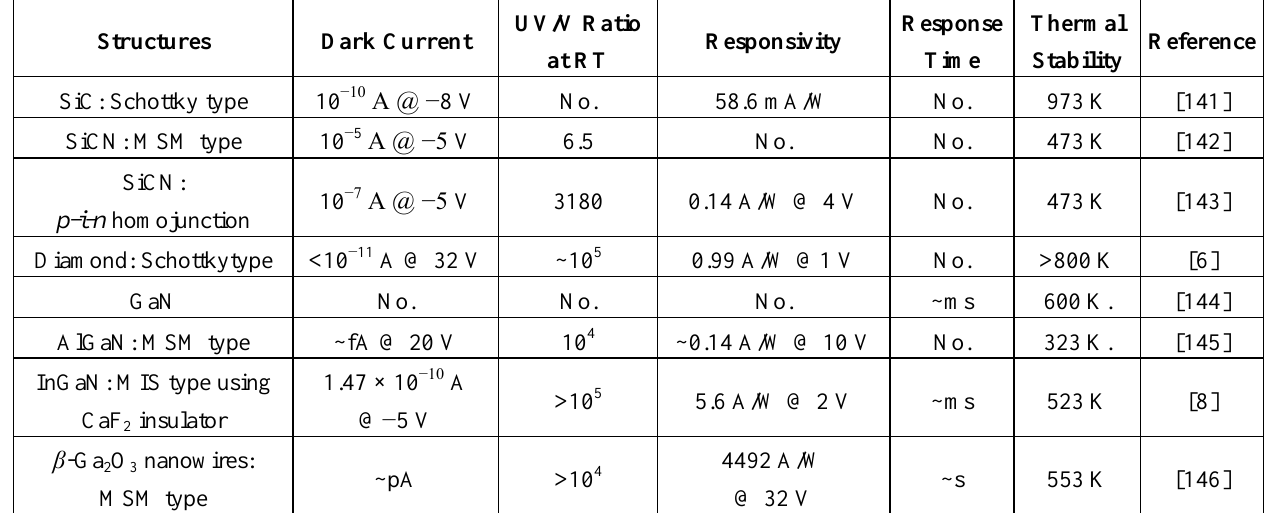
Table 2. Thermally stable photodetectors working in the UV region. UV/V Ratio Structures Dark Current at RT Time